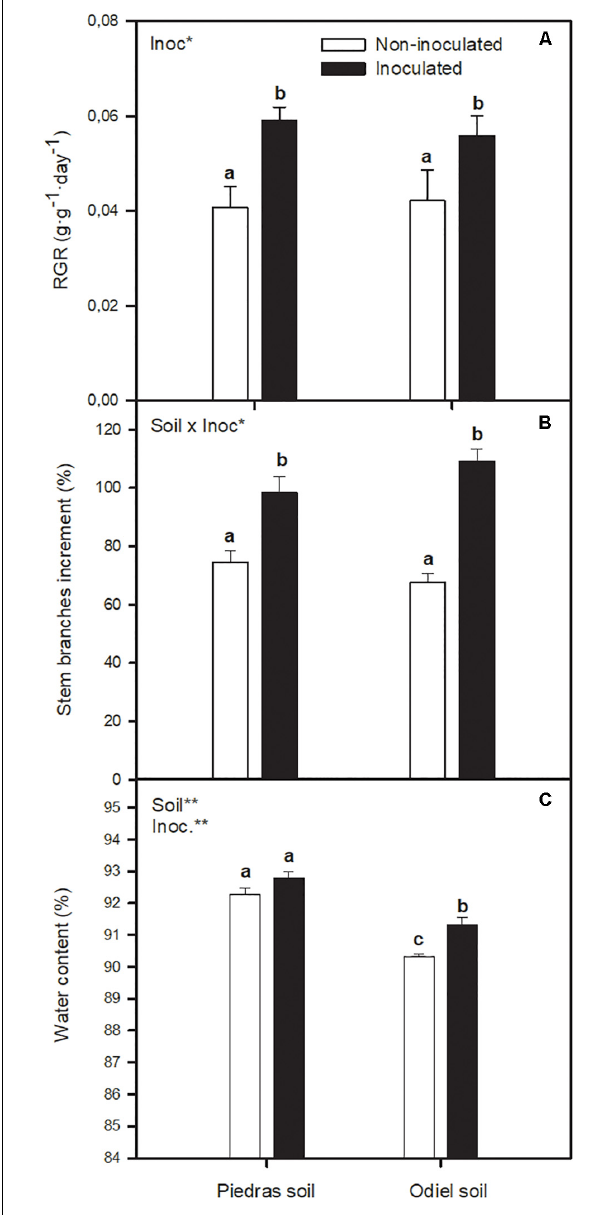
FIGURE 1 | Effect of soil bioaugmentation treatments (non-inoculated and inoculated) with a bacterial consortium integrated by Vibrio neocaledonicus SRT1, Thalassospira australica SRT8 and Pseudarthrobacter oxydans SRT15 on (A) relative growth rate, RGR, (B) number of stem branches and (C) water content of Salicornia ramosissima plants grown in natural soil from non-polluted Piedras and polluted Odiel marshes for 30 days. Values are means ± S.E. ( n = 10). “Inoc” or “Soil” in the upper left corner of the panel indicates main or interaction significant effect (* p < 0.1, ** p < 0.01). Different letters indicate means that are significantly different from each other ( p <